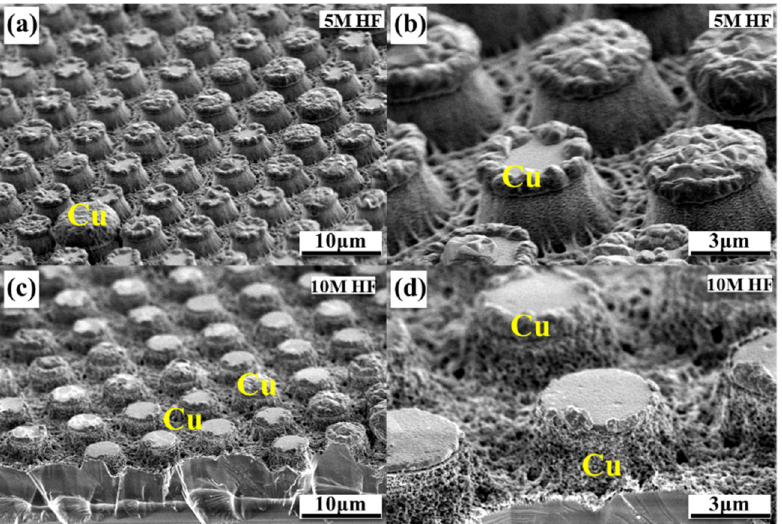
Figure 8. Cross-sectional SEM images (45°-tilt view) of the GaN micropillar arrays obtained with etchants containing different HF concentrations: ( a , b ) 5 M and ( c , d ) 10 M.